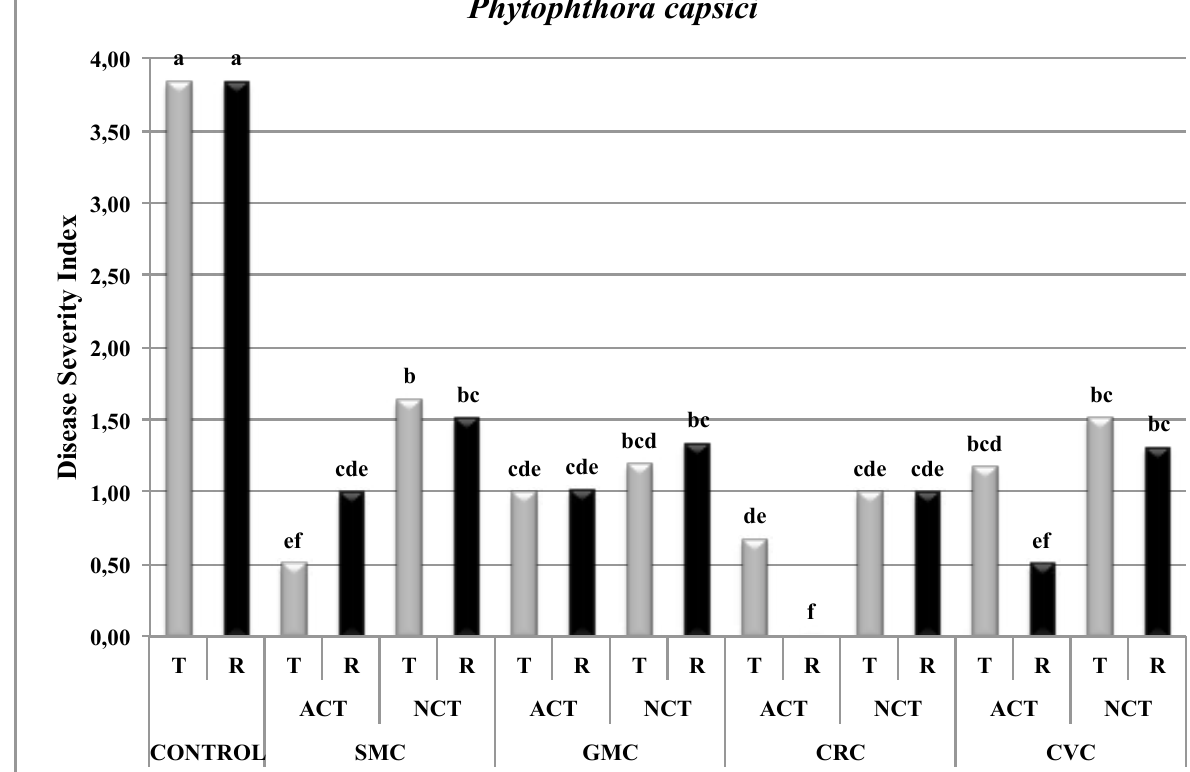
Figure 3. Mean severity of Phytophthora capsici on retreated (R) and non-retreated (T) plants with aerated compost tea (ACT) and non-aerated compost tea (NCT) from spent mushroom compost (SMC), grape marc compost (GMC), crop residues compost (CRC) and crop residues vermicompost (CRV). Applied compost teas were obtained in ratio 1:4 w:v. Controls were retreated (R) or non-retreated (T) with tap water. Readings was performed 15 days after inoculating. Disease index values (Santos et al., 2008) are 0, healthy plant; 1, symptoms beginning; 2, moderate symptoms; 3, severely affected plant; 4, dead plant. Different letters indicate significant differences according to One-Way ANOVA tests ( P